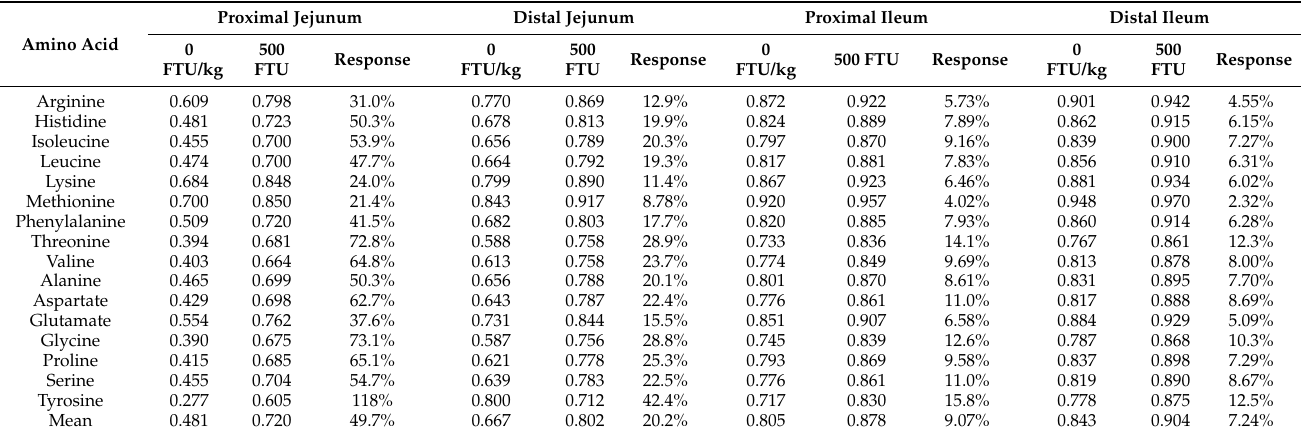
Table 3. Effects of 500 FTU/kg phytase on apparent amino acid digestibility coefficients in four small intestinal segments [adapted from Truong et al.